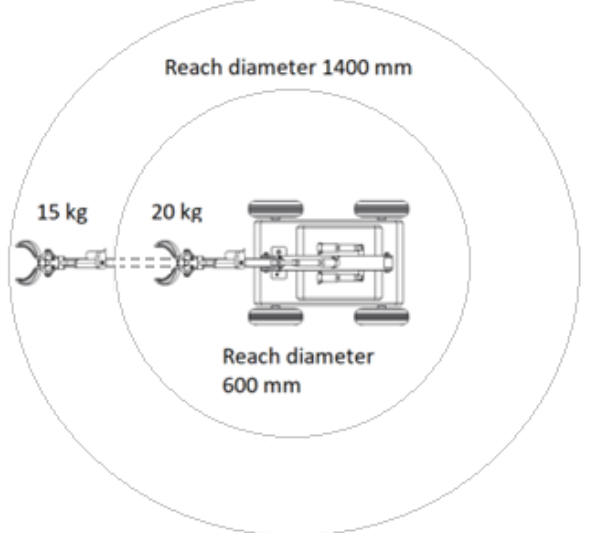
Figure 3. Lifting capacity in relation to